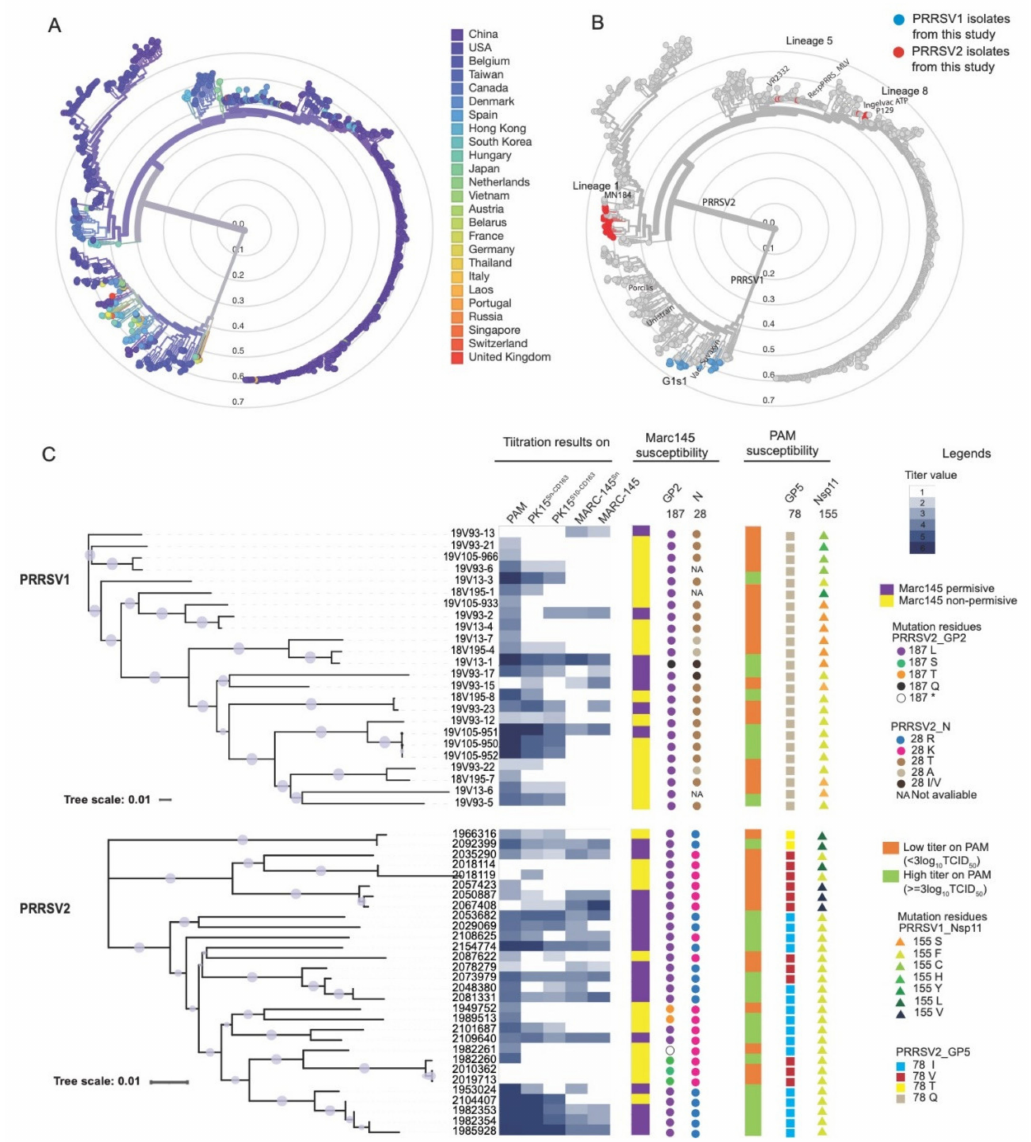
Figure 3. Phylogenetic analysis and the GWAS analysis between genotype and virus-cell tropism for PRRSV1 and PRRSV2 field isolates. ( A ) The phylogenetic tree containing both PRRSV1 and PRRSV2 full-genome sequences with available reference sequences from GenBank, labeled with countries. ( B ) The distribution of the isolates (PRRSV1 and PRRSV2) from the current study in the full-genome phylogenetic tree. ( C ) Phylogenetic and phenotypic correlation analysis. The phylogenetic tree was constructed with an IQ-Tree. The tree and the titration data set were combined. The bootstrap values above 70 were indicated with blue circles in each node of the tree. The heatmap in the first column, besides the tree, represents the titration data tested in the five cell lines, as indicated. The second column represents the residues that are potentially linked to MARC-145 permissiveness. The third column shows the residues that are potentially linked to preferences for PAM. Legends for all the symbols are listed in the figure. The asterisk (*) represents a stop codon in the corresponding